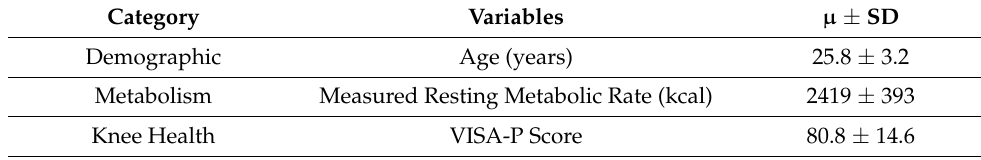
Table 1. Player metabolism, knee health, physique traits and eating behaviours ( n = 22). Category Variables µ ± SD